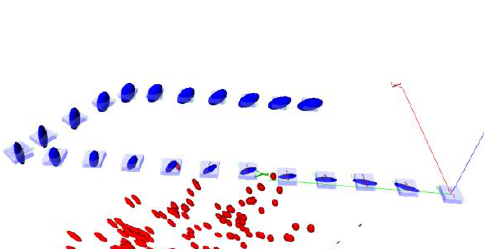
Figure 8. 3D Error ellipses of a minimum-constraint block bundle adjustment of few images in Vihti